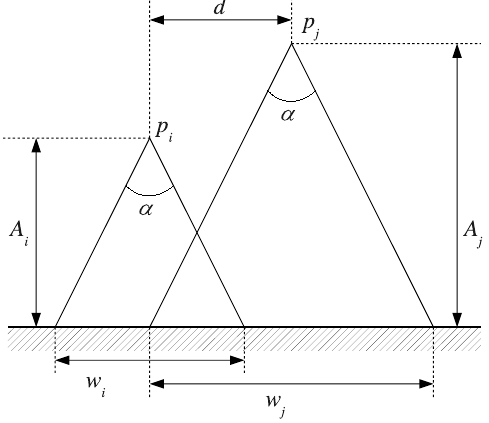
Figure 5. Simple camera model to determine whether two images overlap or not. Given two images gathered at times t vision of α degrees, the observed regions have a diameter of w term d denotes the distance between the image acquisition